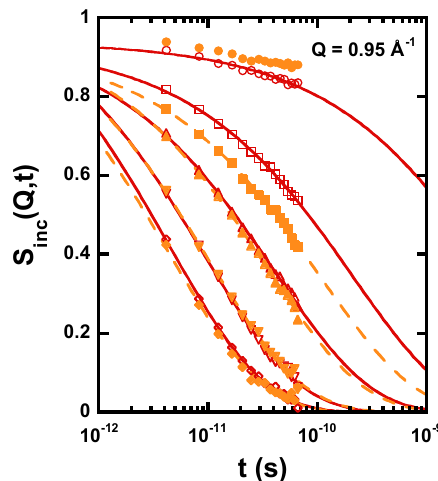
Fig. 4. Fourier-transformed and deconvoluted QENS spectra obtained from FOCUS on EPrec (unfilled) and ePrec (filled) samples at Q-value of 0.95 at the five temperatures Å (cid:6)(cid:7) investigated: 250 K (circle), 290 K (square), 320 K (up- triangle), 360 K (down-triangle) and 400 K (diamond). Lines are Kohlrausch-Williams-Watts (KWW) fits with β = 0.5.